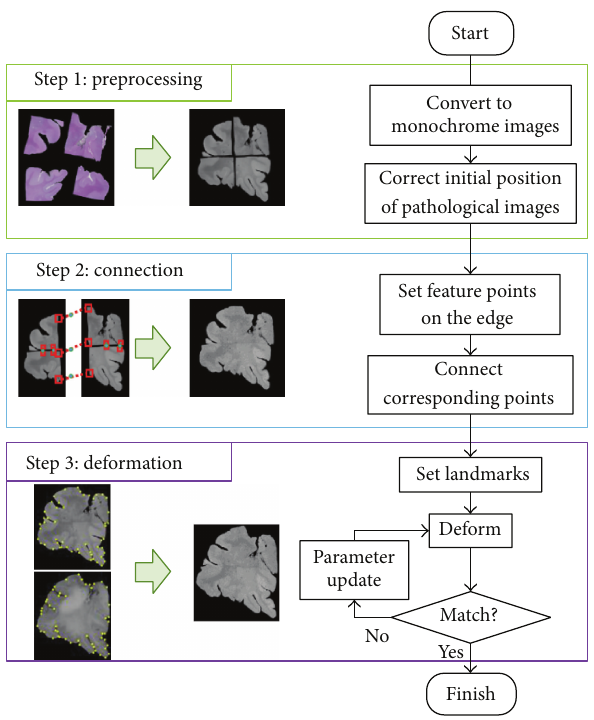
Figure 1: Flow of proposed method.